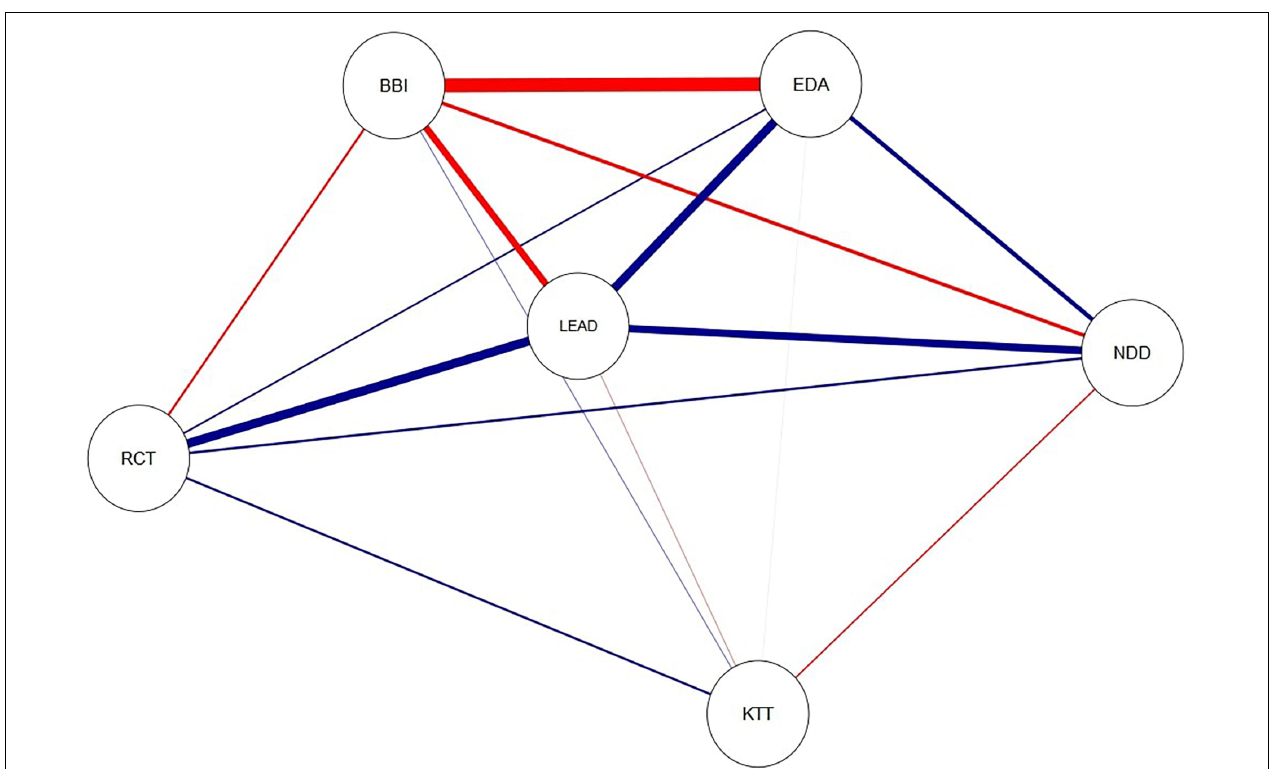
FIGURE 2 | Latent variable correlation network Study 2. Abbreviation RCT refers to reflective-collaborative theory, KTT to knowledge transmission theory, NDD (New digital demands) to developmental orientation for digital pedagogy, LEAD to servant leadership, EDA to work engagement, and BBI to burnout symptoms. Blue edges in the figure refer to positive relations, and red edges to negative relations. The width of the edges corresponds to the absolute value of the correlations: the higher the correlation, the thicker the edge (see Epskamp et al.,